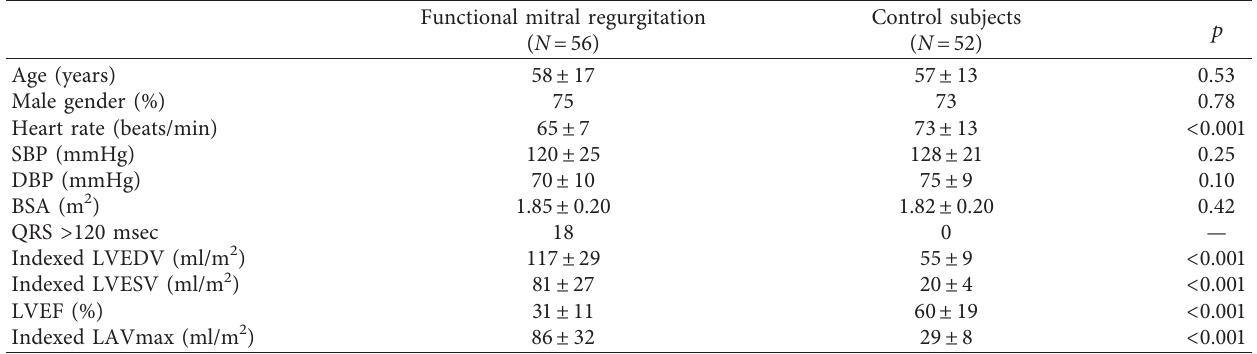
Table 1: General characteristics of patients with functional mitral regurgitation and control subjects.